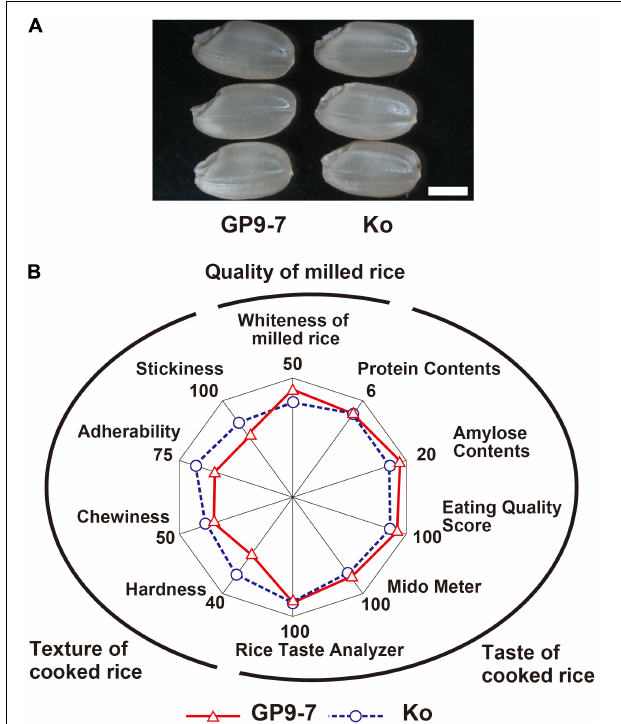
FIGURE 8 | Grain quality-related traits of GP9-7 harvested in the Tsukuba field in the fall of 2018. (A) A morphological comparison of typical hulled rice grains of Koshihikari and GP9-7. Scale bar: 2 mm. (B) Summary of rice texture and taste quality tests. Values for Koshihikari are indicated with blue circles with broken lines and values for GP9-7 are represented with red triangles with solid